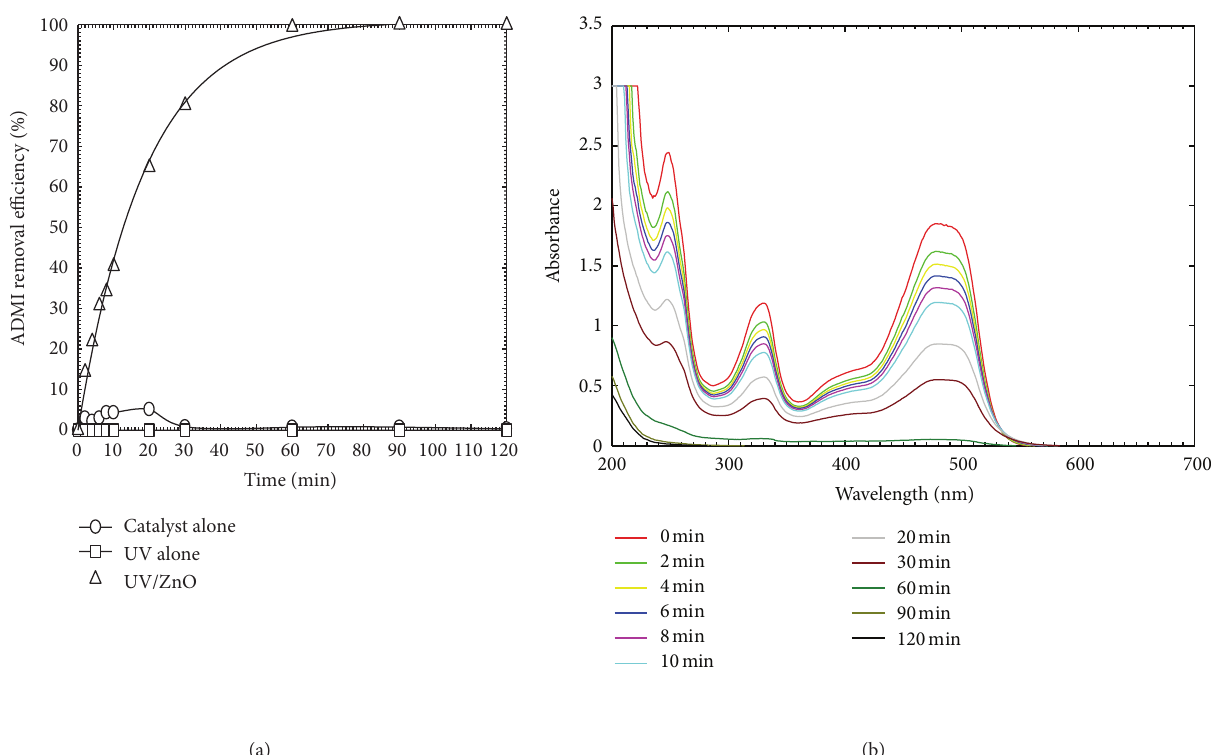
Figure 2: (a) Synergic effect of UV and ZnO on UV/ZnO photocatalytic system. (b) UV spectra of OG under UV/ZnO decolorization. The conditions were initial dye concentration of 50 mgL −1 , ZnO loading of 60g m −2 , light intensity of 2.1mWcm −2 , and reaction time during 120min.